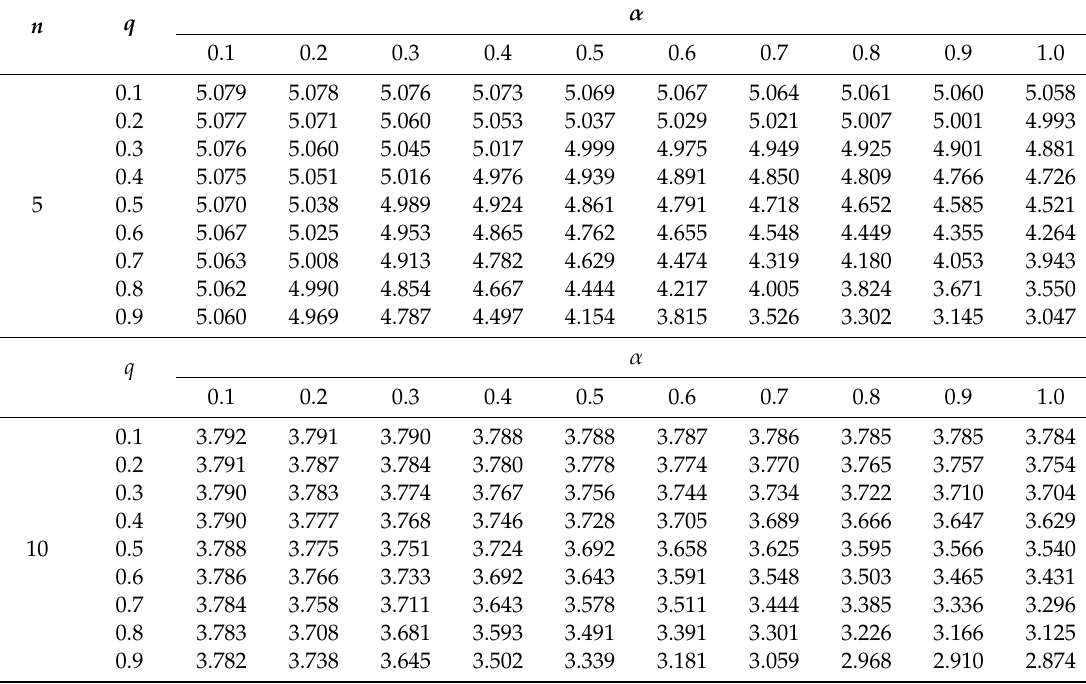
Table 1. Values for the auxiliary information-based generally weighted moving average (AIB-GWMA-t) charts when ρ = 0, ARL 0 ≈